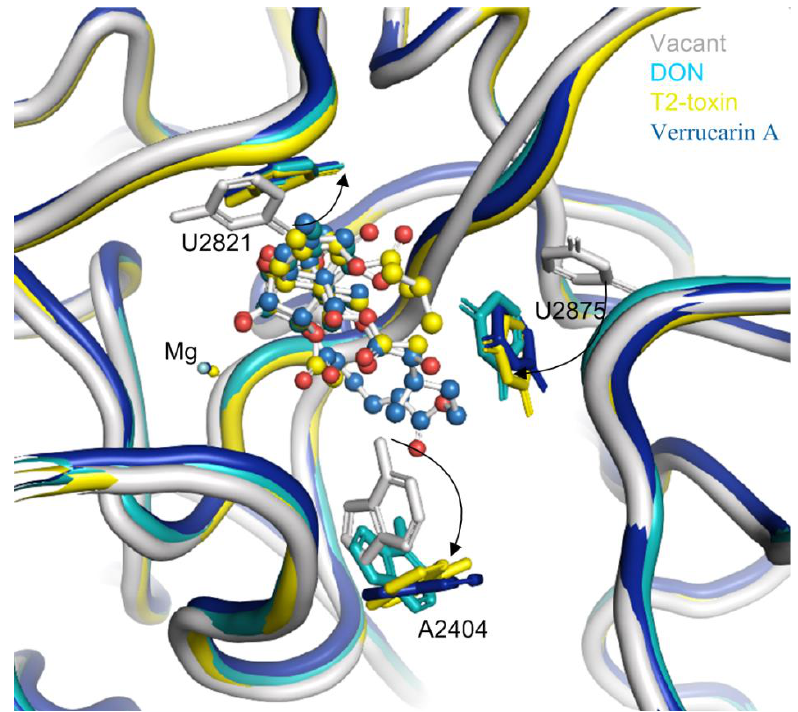
Figure 4. The conformation changes of several nucleobases around the binding pocket in 25S rRNA upon trichothecenes binding. The vacant 25S rRNA was taken as the reference and shown in gray, the 25S rRNA bound with DON was in light blue, the 25S rRNA bound with T-2 toxin was in yellow, and that bound with verrucarin A was in deep blue.